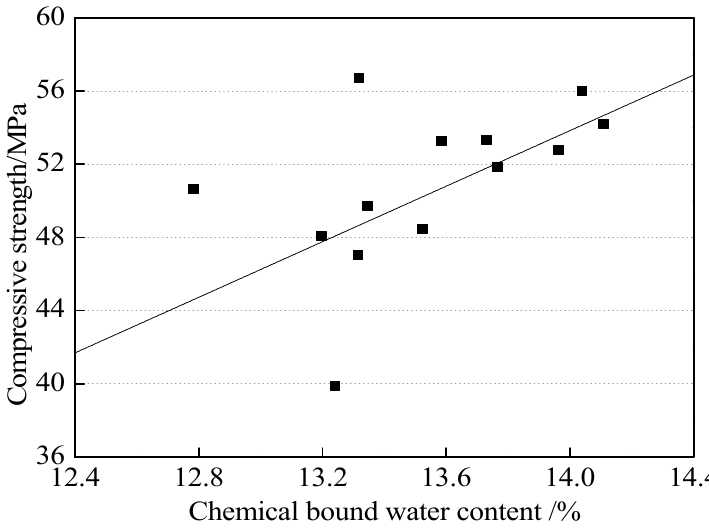
Figure 14. Relationship between compressive strength and chemical binding water content.